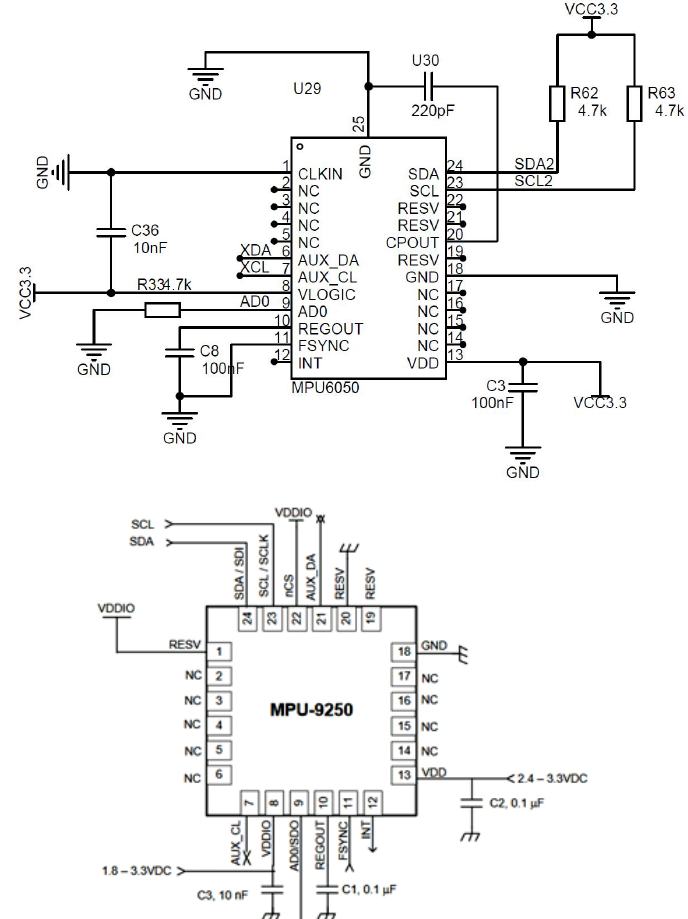
Figure 10. Two kinds of IMU circuit diagram.